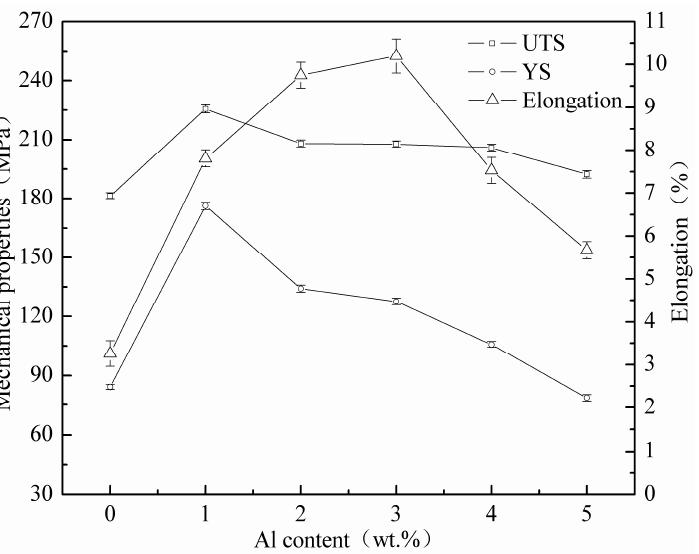
Figure 5. The mechanical properties of as-cast Mg-11Gd-2Y-1Zn with different Al addition.